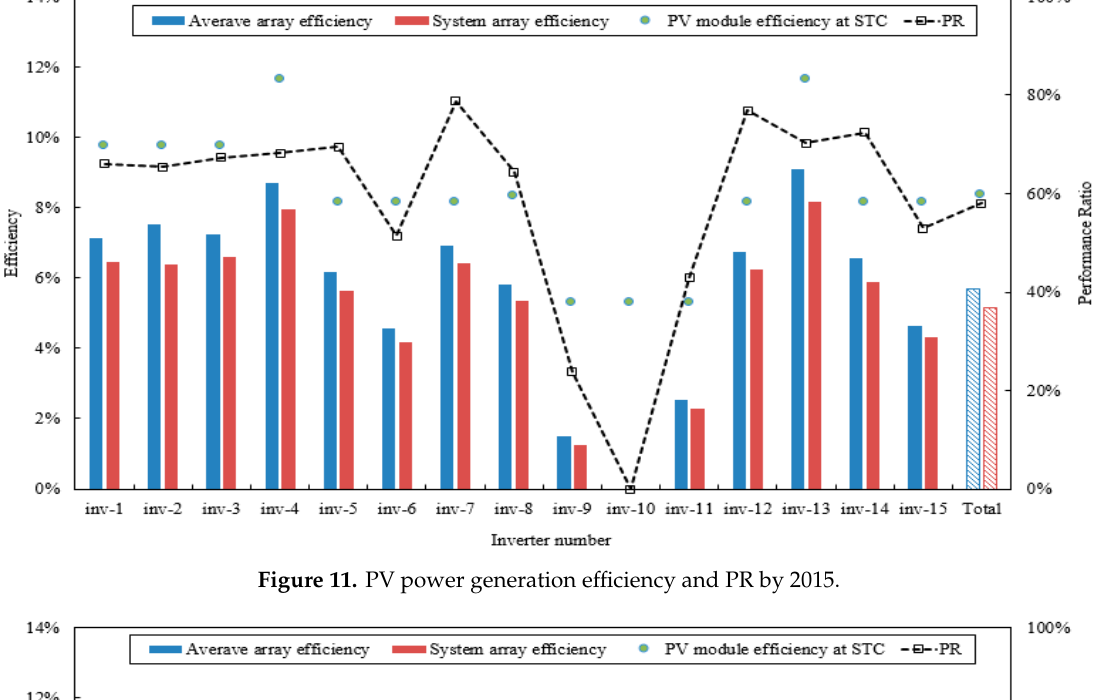
Figure 11. PV power generation efficiency and PR by 2015.